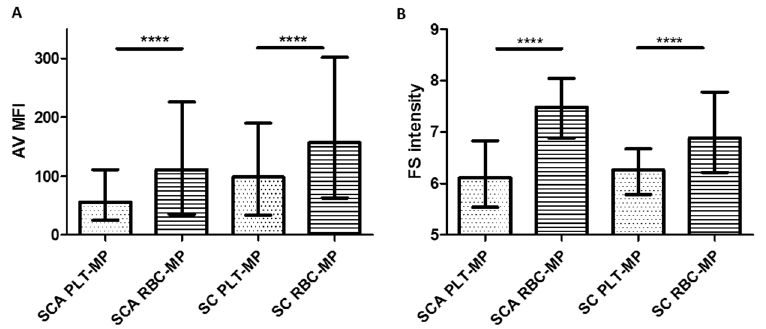
Fig 2. Comparison of RBC- and PLT-derived MP characteristics between SCA and HbSC patients. A : mean fluorescence intensity of annexinV; B : mean forward scatter index. The value distributionsare represented as box and whiskers (min to max). **** :p < 10 − 4 .